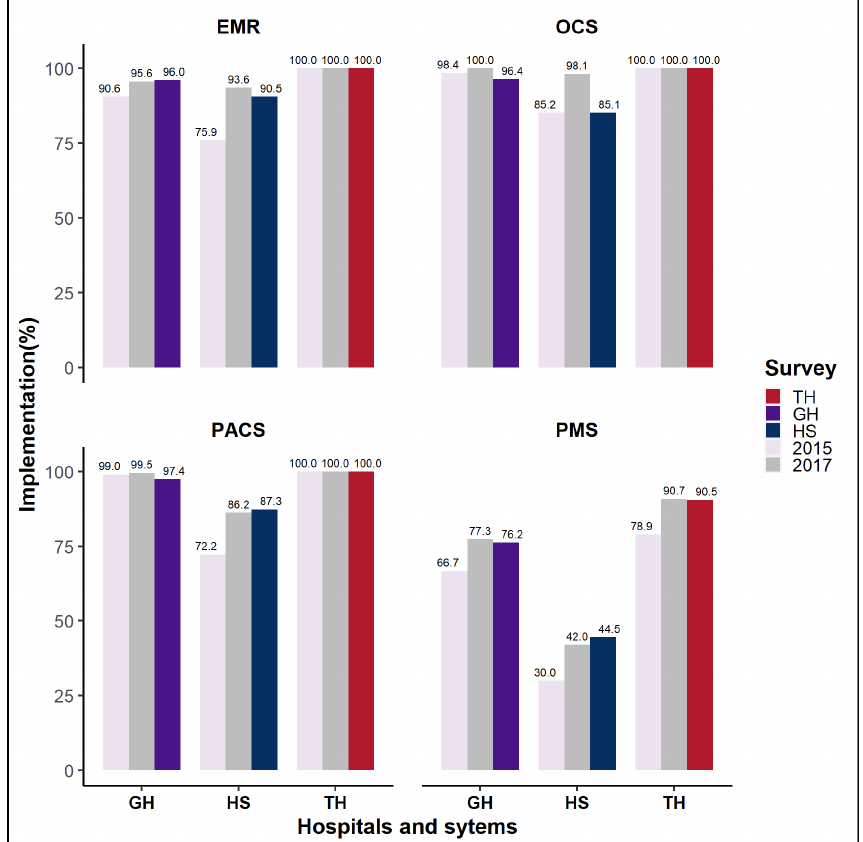
Figure 2. Major hospital IT systems and adoption rates in 2020. Abbreviations: EMR, electronic medical record; OCS, order communication system; PACS, picture archiving and communication system; PMS, pharmacy management system; TH, tertiary hospital; GH, general hospital; HS,